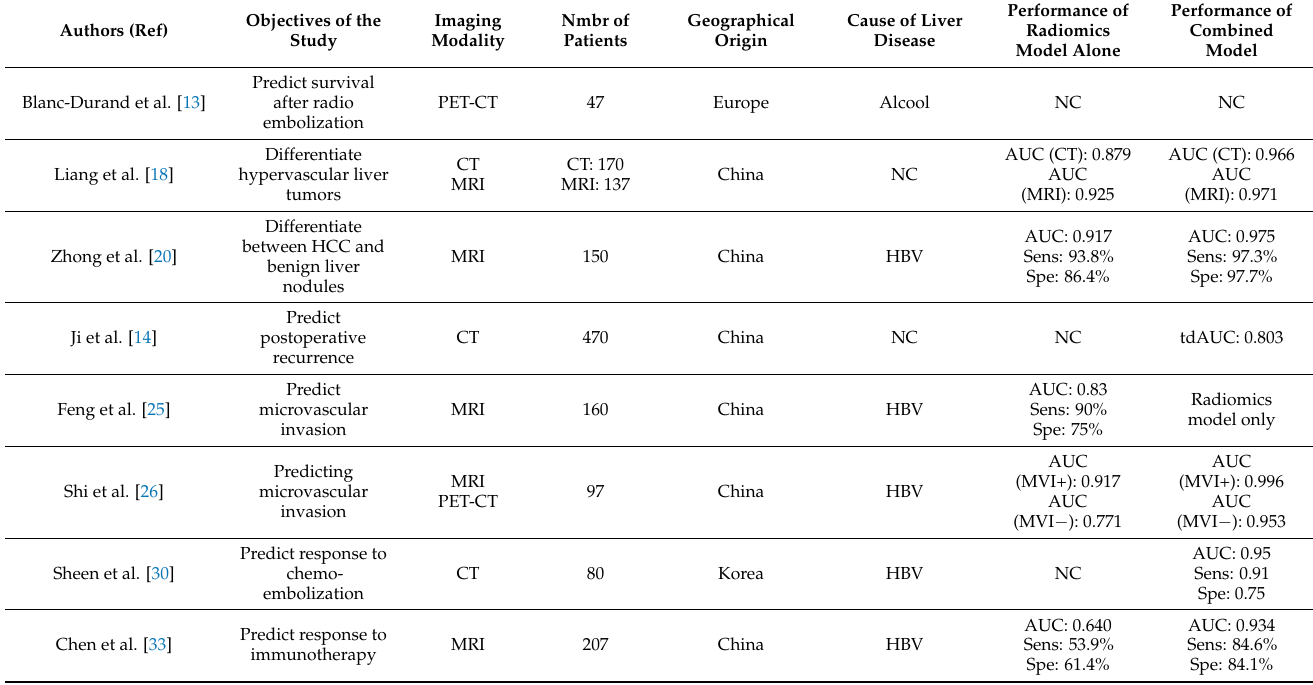
Table 1. Main characteristics of the studies